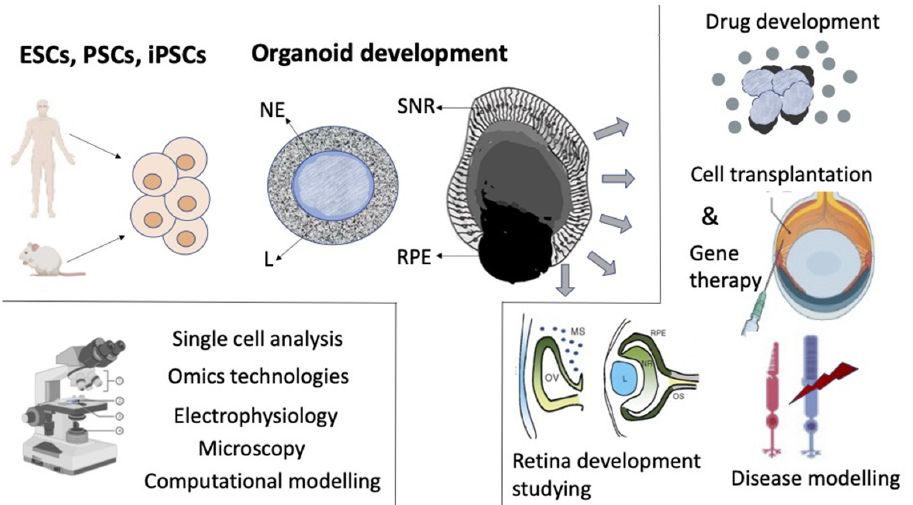
Figure 6. Three-dimensional retinal organoids obtained from pluripotent stem cells mimicking in vivo development. ESCs—embryonic stem cells; PSCs—pluripotent stem cells; iPSCs—induced pluripotent stem cells; NE—neuroepithelium; L—laminin; RPE—retinal pigment epithelium. SNR—stratified neural retina. Left box at the bottom: the methods of retinal organoids’ research. Right box: the directions of retinal organoids’